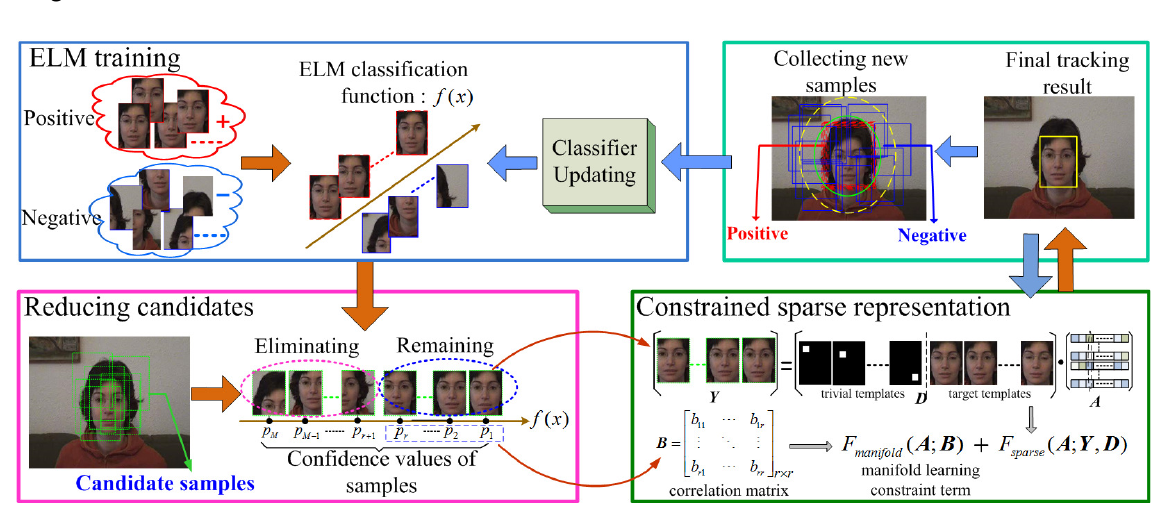
Figure 1. Flowchart of the proposed tracking